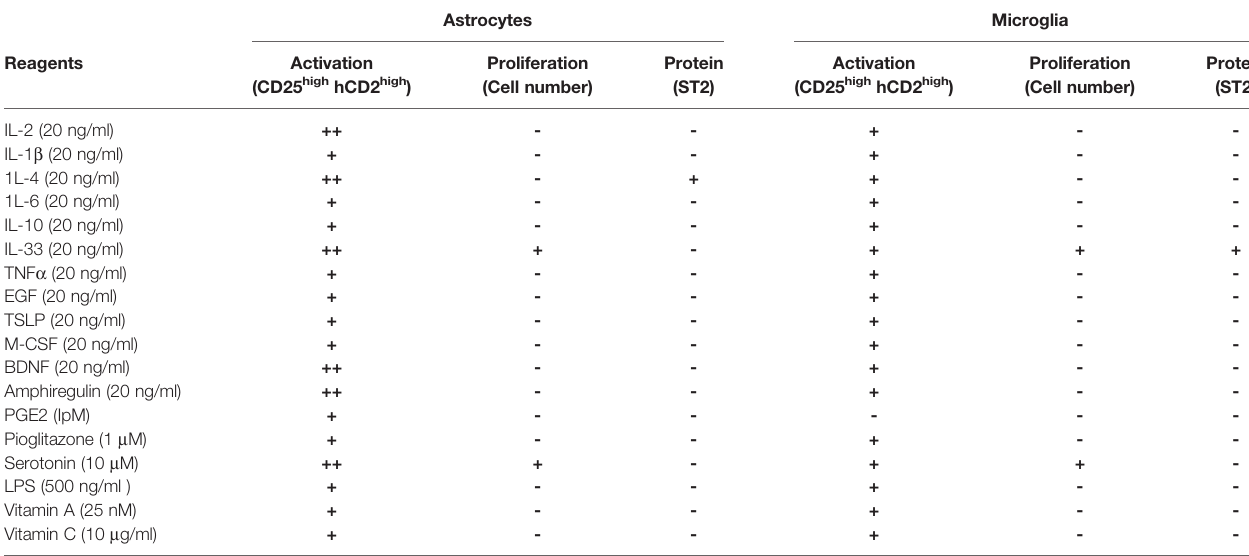
TABLE 1 | The effect of various factors on Treg activation and